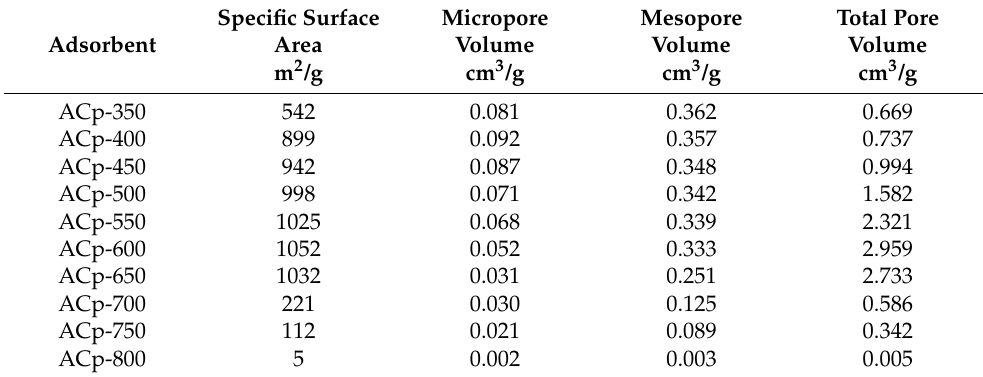
Adsorbent Table 1. Parameters of the pore structure calculated from nitrogen adsorption isotherms.